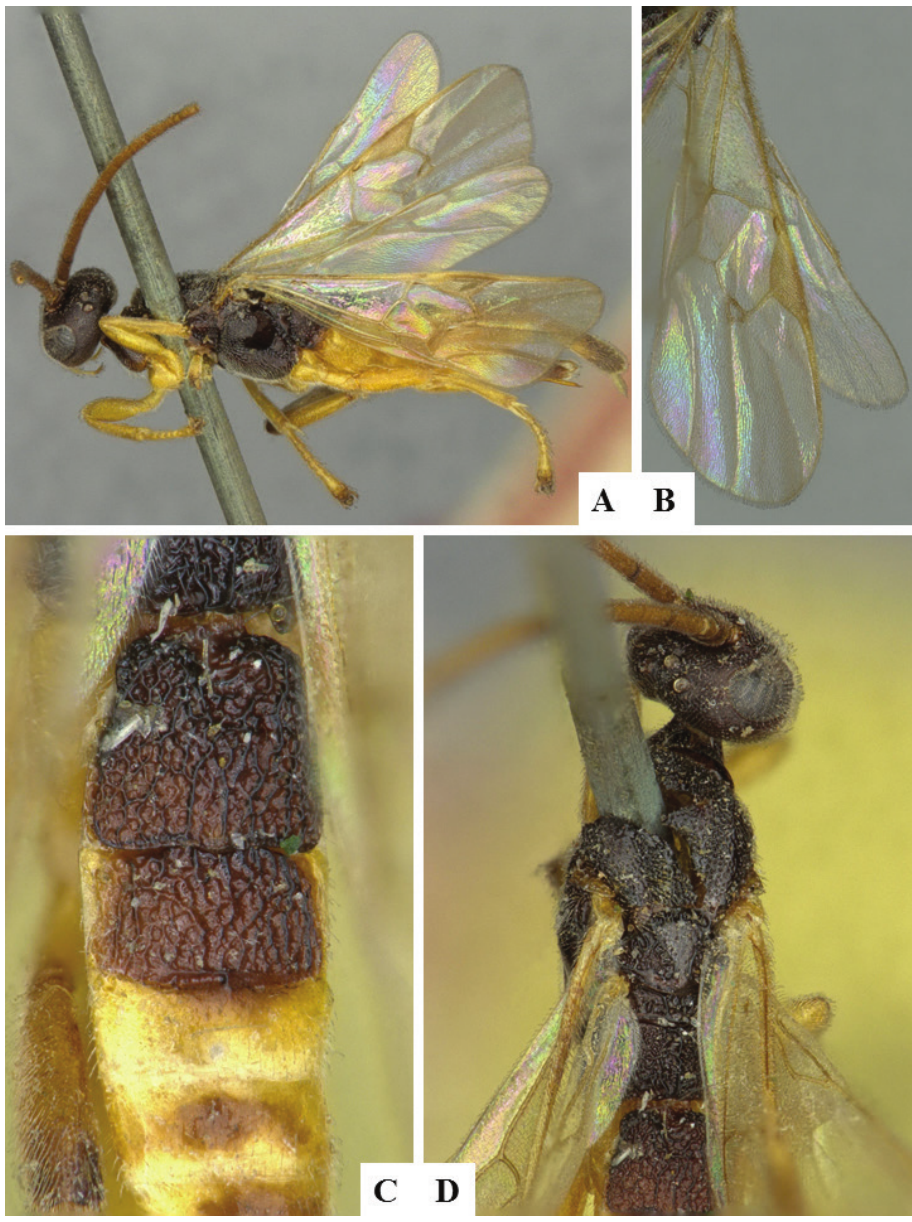
Figure 26. Hygroplitis melligaster. A Habitus, lateral B Wings C Metasoma (partially), dorsal D Head and mesosoma,